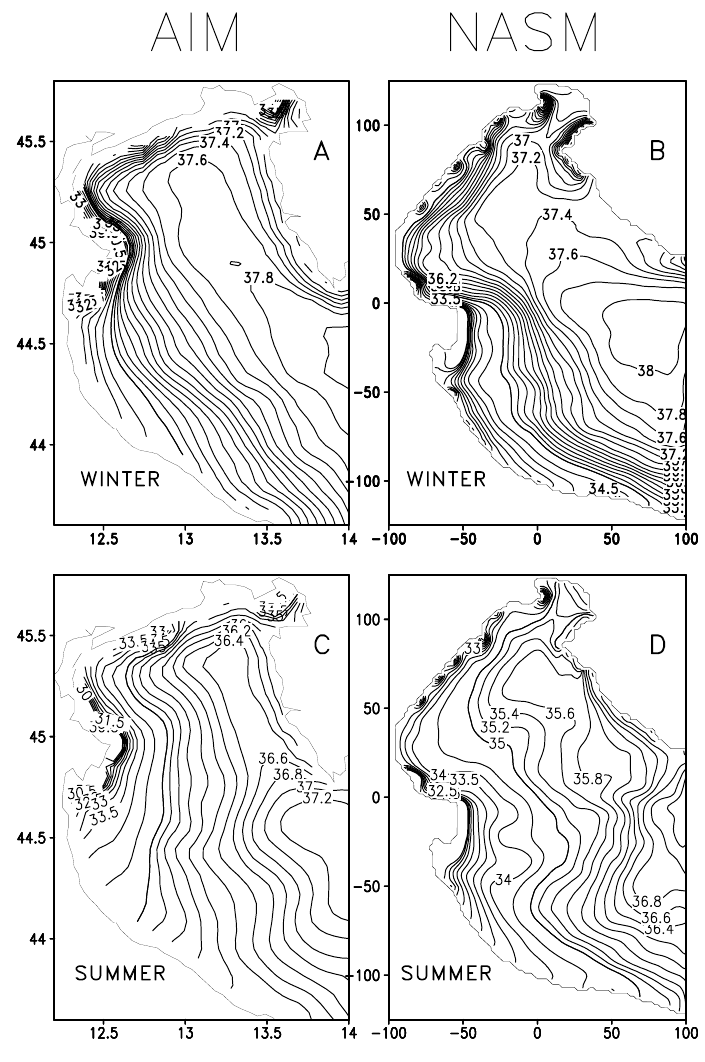
Fig. 18. Northern Adriatic Shelf Model (NASM) surface salinity distri- bution compared with the correspond- ing AIM simulation. (A) : AIM win- ter, (B) : NASM winter, (C) : AIM sum- mer, (D) : NASM summer. Contour interval is 0.5psu for salinity values < 35.0psu and 0.2psu for salinity val- ues > 35.0psu. Seasons definition as in Artegiani et al.